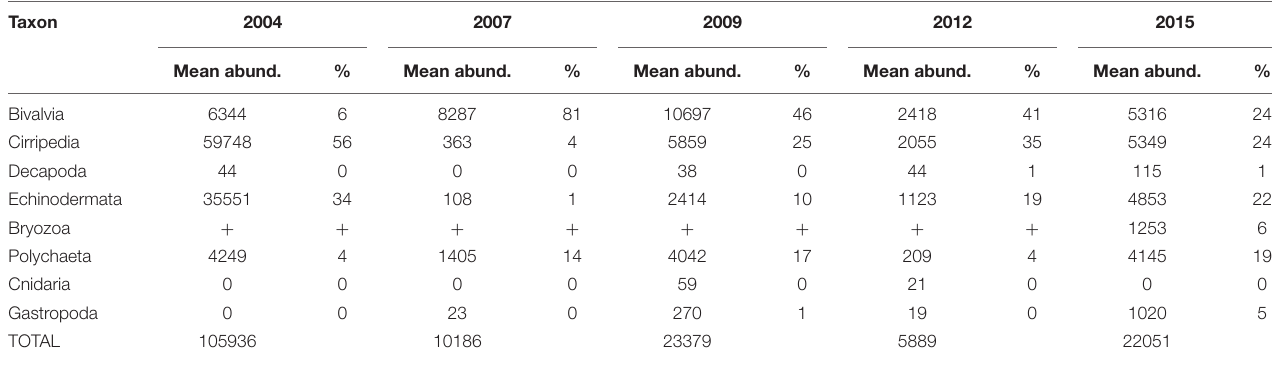
number of “species” was lower, both due to more than one OTU often being assigned to the same species (different